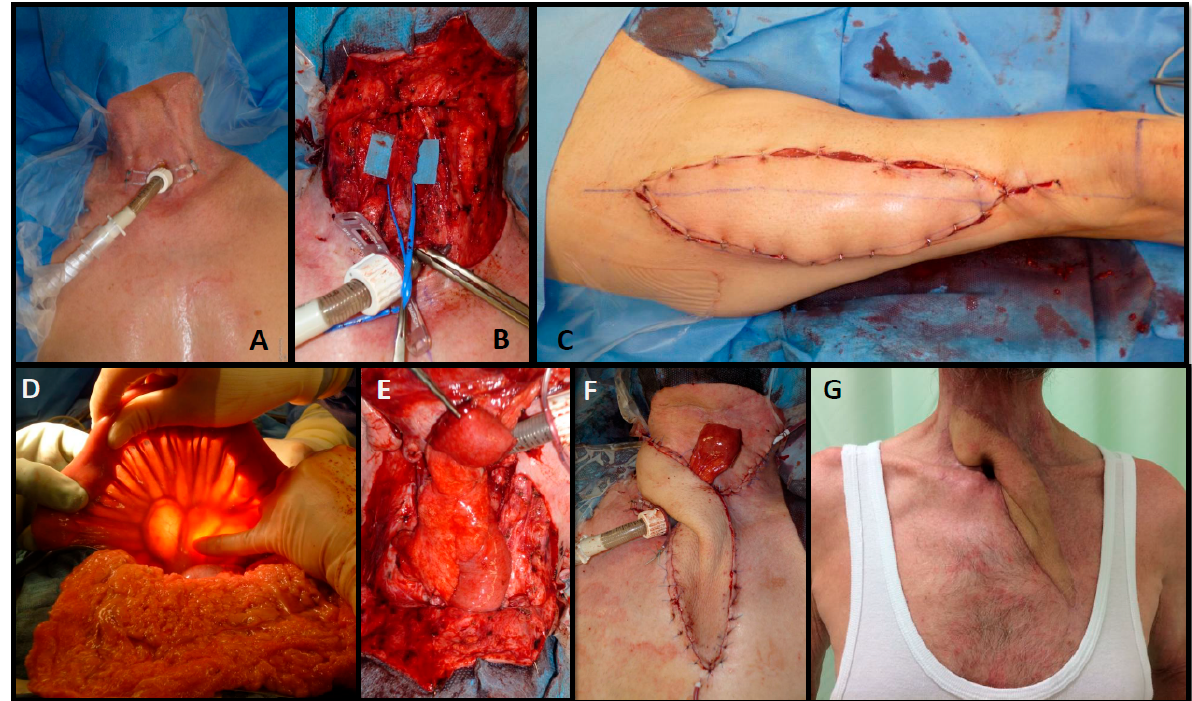
Figure 4. Sixty-six-year-old male suffering from a pharyngotracheal fistula after pharyngolaryngectomy ( A ). The esophagus was occluded over 7 cm due to a post-radiotherapy stenosis and the patient was fed via a percutaneous gastrostomy tube for 7 years ( B ); intraoperative view of the esophagus remnant. Reconstruction was performed using an ALT flow-through flap ( C ). The digestive tract was reconstructed using a free jejunum segment ( D ); intraoperative view to select the jejunum segment ( E ); intraoperative view after inset that was anastomosed distally to the outflow of the ALT ( F ); intraoperative view after wound closure; a segment of the jejunum was separated for postoperative perfusion monitoring ( G ); long-term result; the patient was eating and drinking normally.